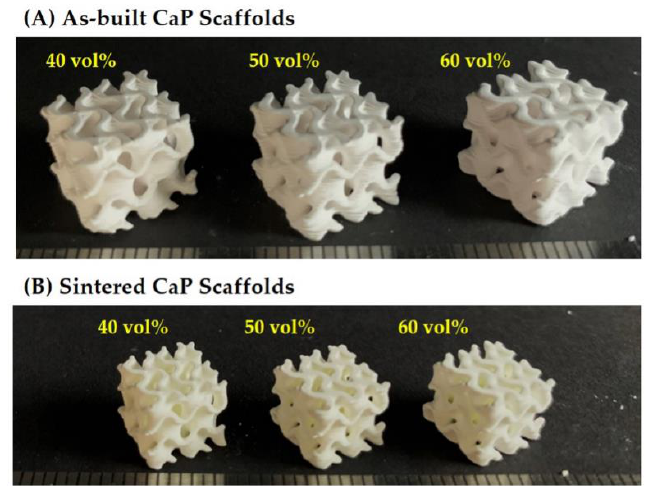
Figure 2. Optical images of ( A ) the as-built and ( B ) sintered CaP scaffolds with hierarchically porous structures manufactured with a range of camphene-camphor amounts (40 vol %, 50 vol %, and 60 vol %; scale = 1 mm).